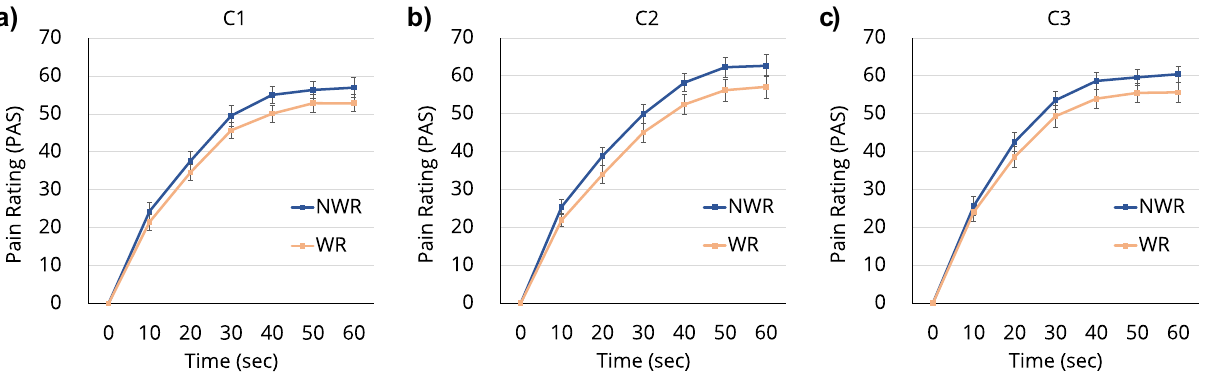
Figure 1. Reported PAS ratings by participants in the three conditions. Each participant rated their perceived pain level on the PAS every 10 s during a 60-s pain presentation.